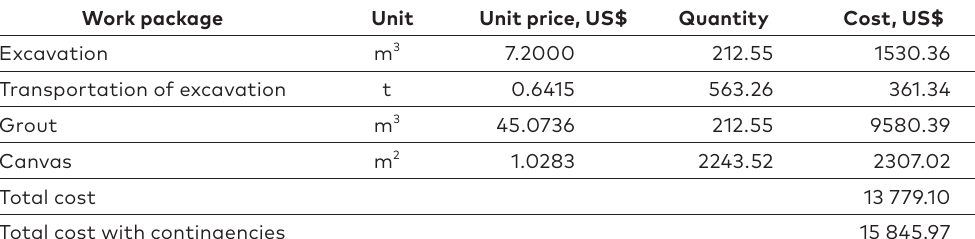
Table 5. Unit prices and costs of grout filled bags